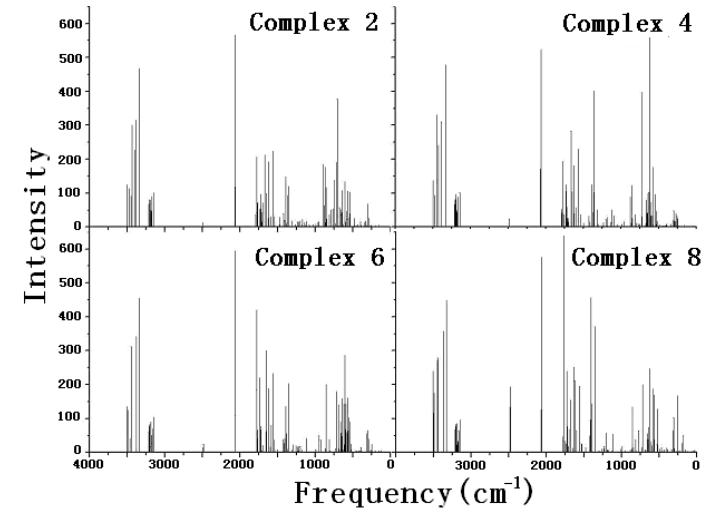
Fig. 4 IR spectra of complexes 2, 4, 6 and